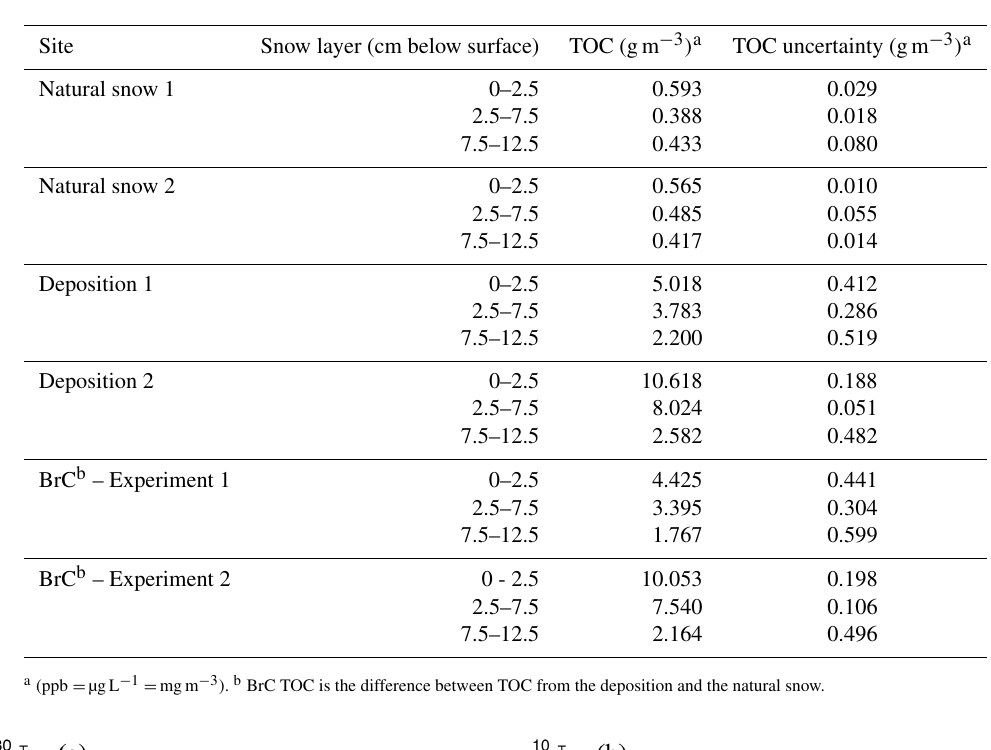
Table 2. TOC concentrations for the natural snowpack and snow after deposition.